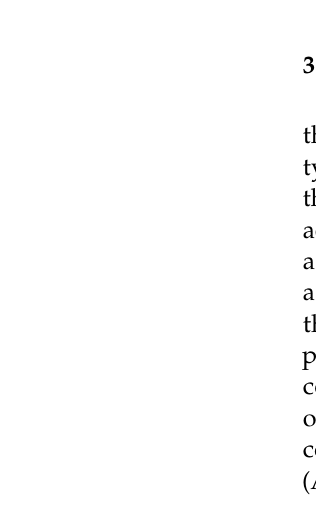
Table 4. Effective dose coefficients for inhaled uranium particulates for